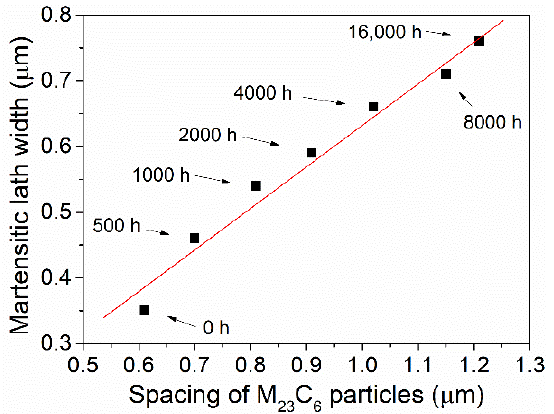
Figure 6. The relation between the lath width of martensite and the spacing of M 23 C 6 precipitates.